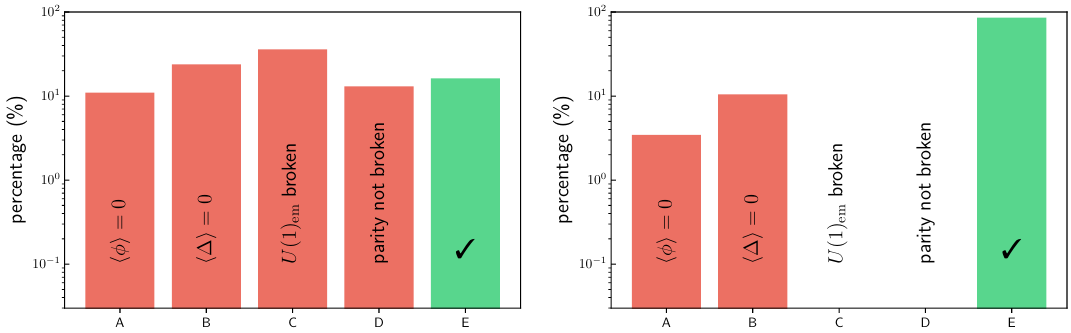
Figure 4 . Similar to (cid:12)gure 3 except that the potential parameters are generated with additional constraints given by eq. (5.1) and eq. (5.2) so that the probability of obtaining type E vacua is signi(cid:12)cantly enhanced. Left : all potential parameters are positive, (cid:11) 1 ; 2 ; 3 are suppressed by a small factor and (cid:12) 1 ; 2 ; 3 = 0. The percentages are 11.0% (A), 23.9% (B), 35.9% (C), 13.0% (D), 16.2% (E). Right : in addition to the constraints used in the left panel, we require that (cid:21) 2 = (cid:21) 4 = (cid:26) 4 = 0, (cid:26) 3 > 2 (cid:26) 1 . The percentages are 3.4% (A), 10.5% (B), 0 (C), 0 (D), 86.0%